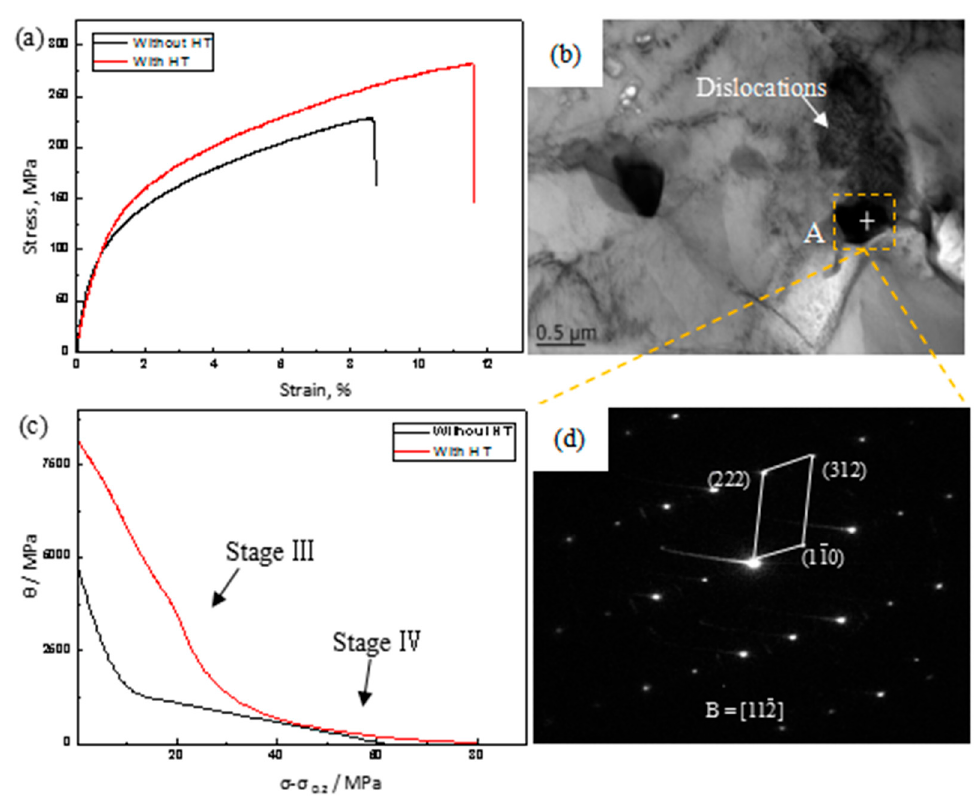
Figure 7. The tensile properties and bright-field TEM image of ECAPed Mg-9Al-1Si-1SiC composites: ( a ) typical tensile stress–strain curves; ( b ) dislocations; ( c ) work hardening curves; ( d ) selected area diffraction patterns of point A.